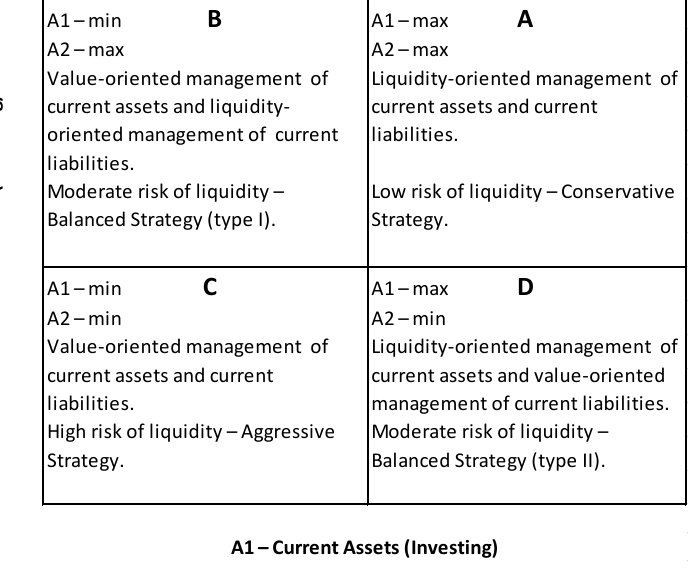
Fig. 2. Types of strategies for working capital